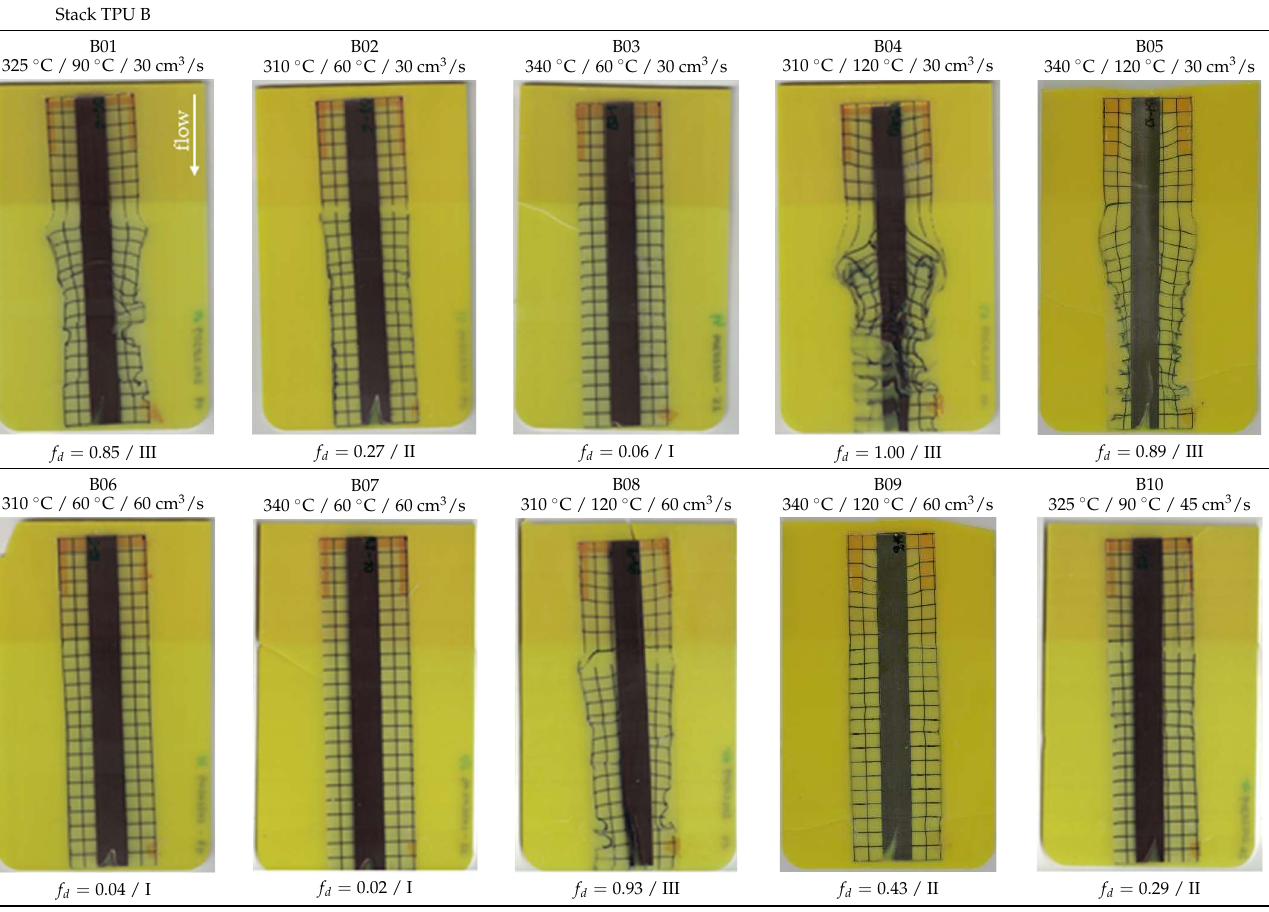
Table 1). The averaged distortion factors f d and categorizations (as defined in Section 2.3)